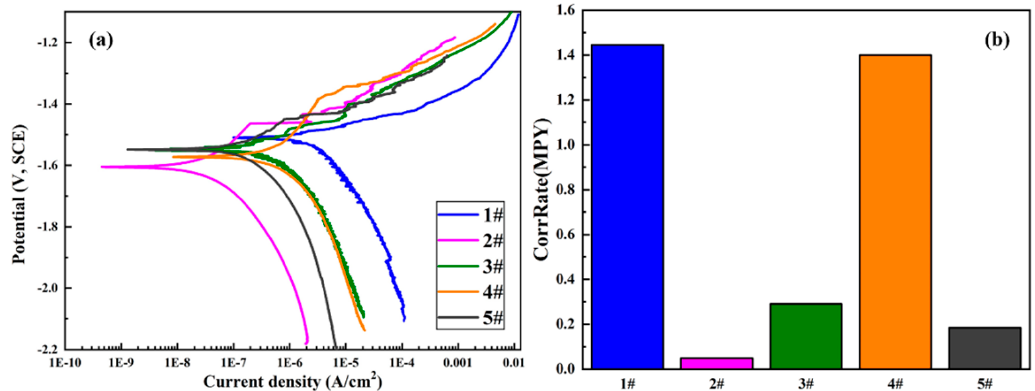
Figure 8. ( a ) PDP (potentiodynamic polarization) curves and ( b )corrosion rate of MAO-WE43 and GelMA / MAO-WE43 samples. 1#: MAO-WE43; 2#: 1GelMA / MAO-WE43; 3#: 5GelMA / MAO-WE43; 4#: 10GelMA / MAO-WE43; 5#: 15GelMA / MAO-WE43. Table 3. Parameters of the PDP curves of MAO-WE43 and GelMA / MAO-WE43 samples. Sample Processing Mode